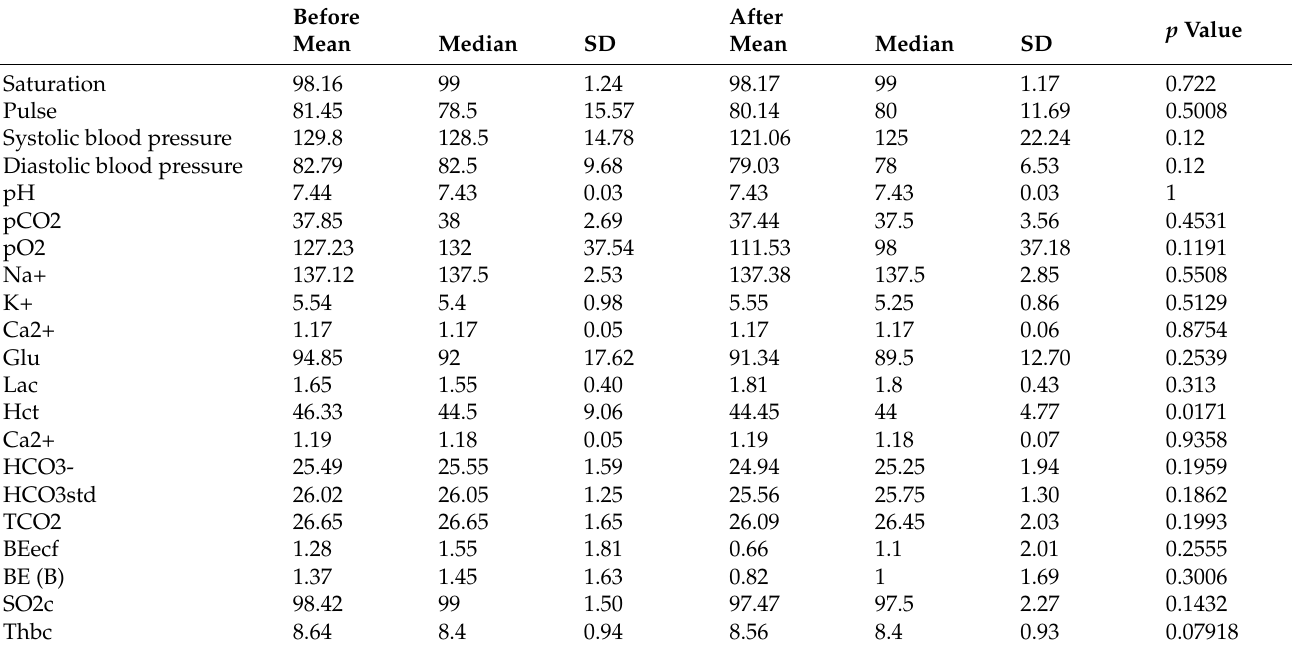
Table 5. Results of capillary blood gas analysis and basic parameters for the surgical mask using the Wilcoxon signed-rank test. A p value < 0.05 was considered statistically significant. Statistically significant results are shown in bold.